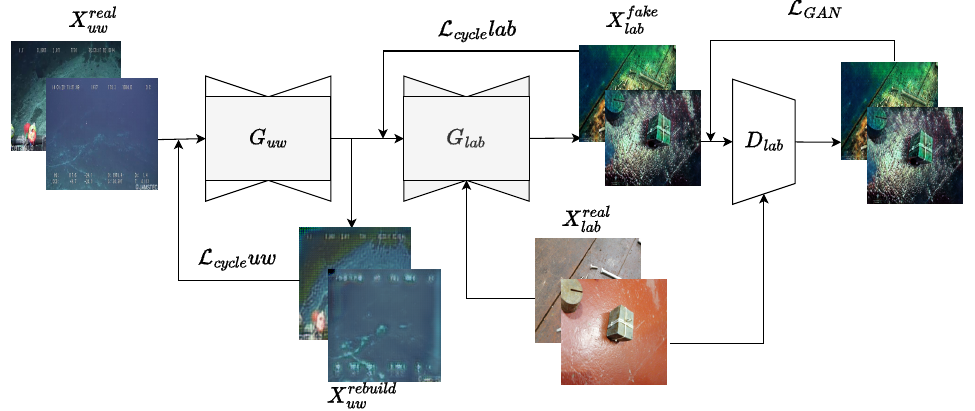
Figure 1. Cyclegan Model for Underwater Data